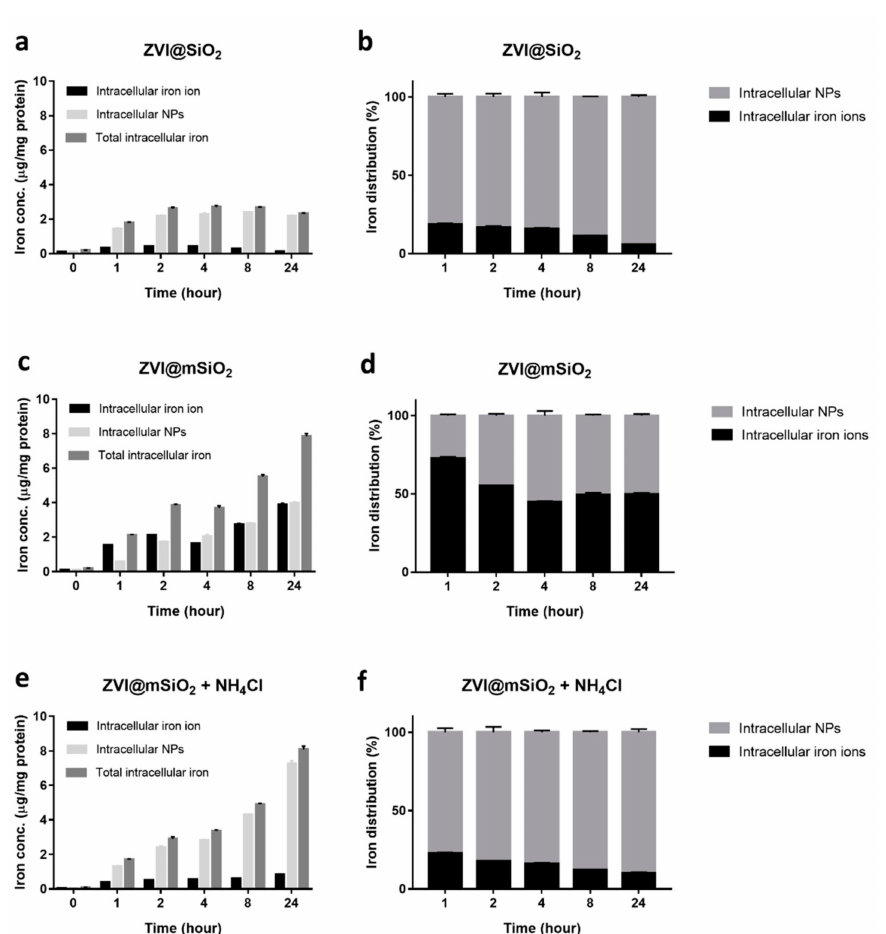
Figure 4. Intracellular iron ion release profiles of 10 µ g / mL ZVI@SiO 2 - and ZVI@mSiO 2